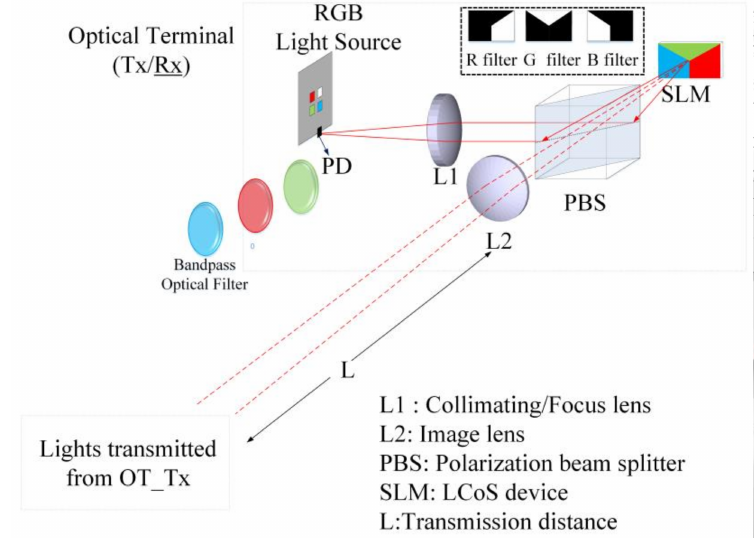
Figure 2. Design of OT_Rx for reverse directional link.